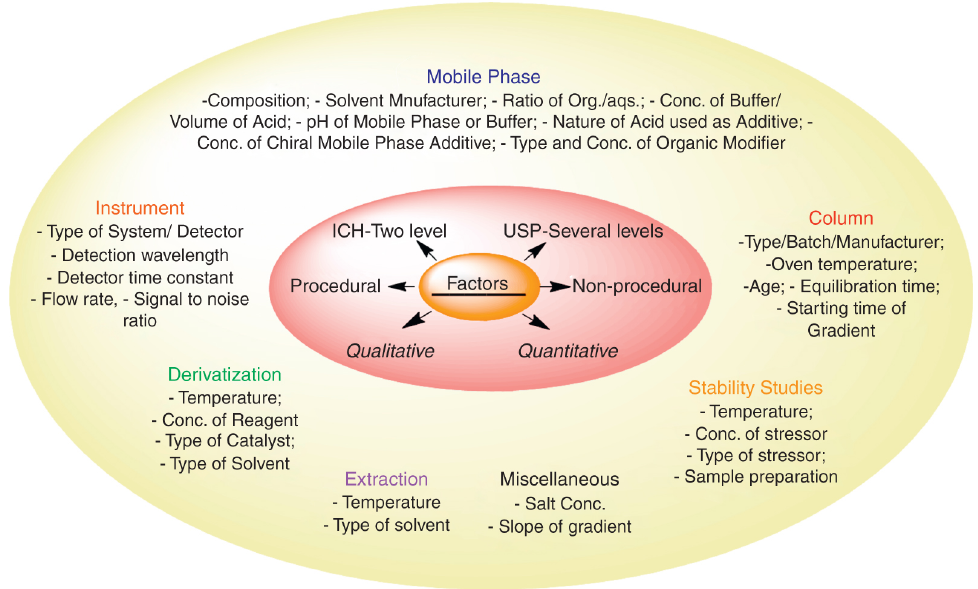
Figure 4: Various factors chosen while the application of design procedures during pharmaceutical HPLC analyses.